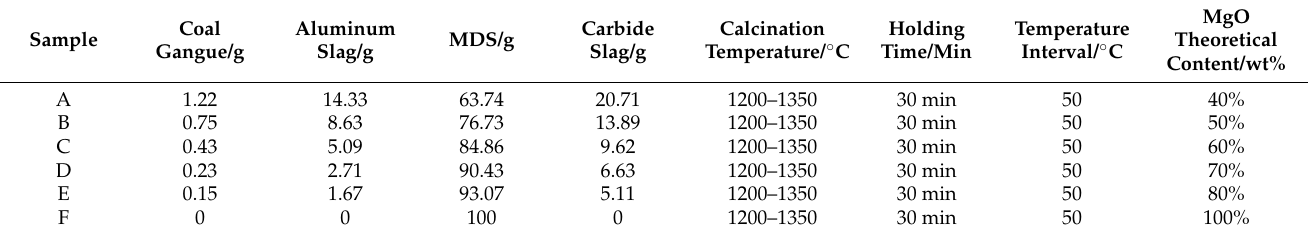
Table 3. Compositions of raw mixes in the experiment with different calcination temperatures.